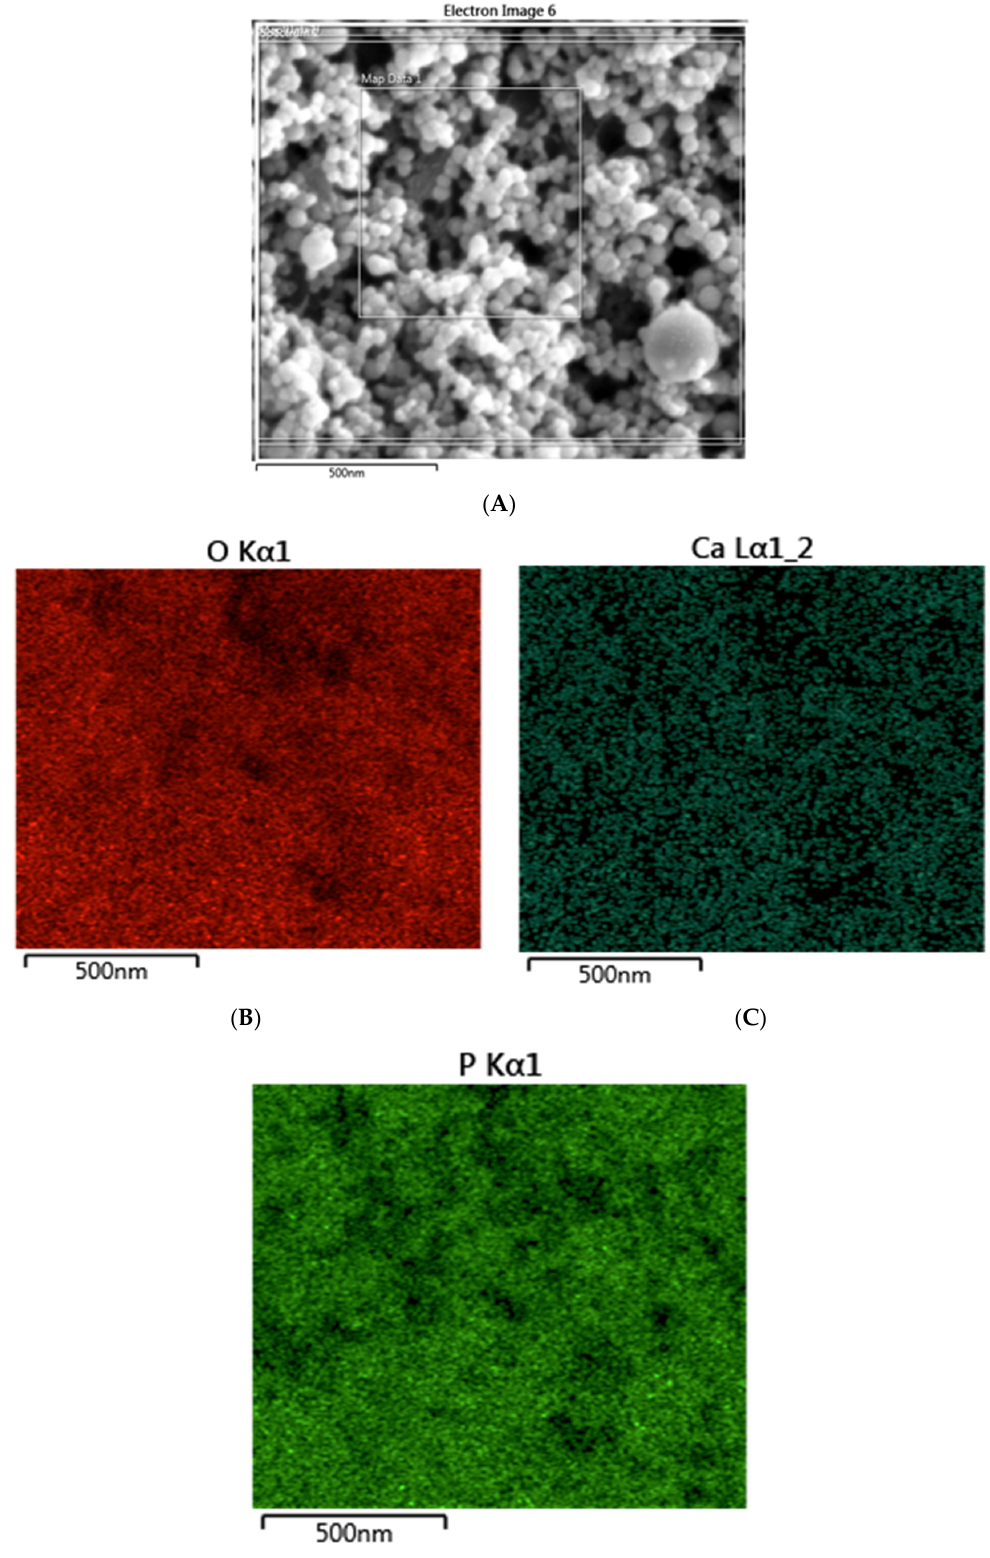
Figure 2. Energy-Dispersive X-ray (EDX) elemental mapping of the n-HA nanoparticles ( A ) showing evidence of oxygen ( B ), calcium ( C ), and phosphorus ( D ) in the hydroxyapatite samples.